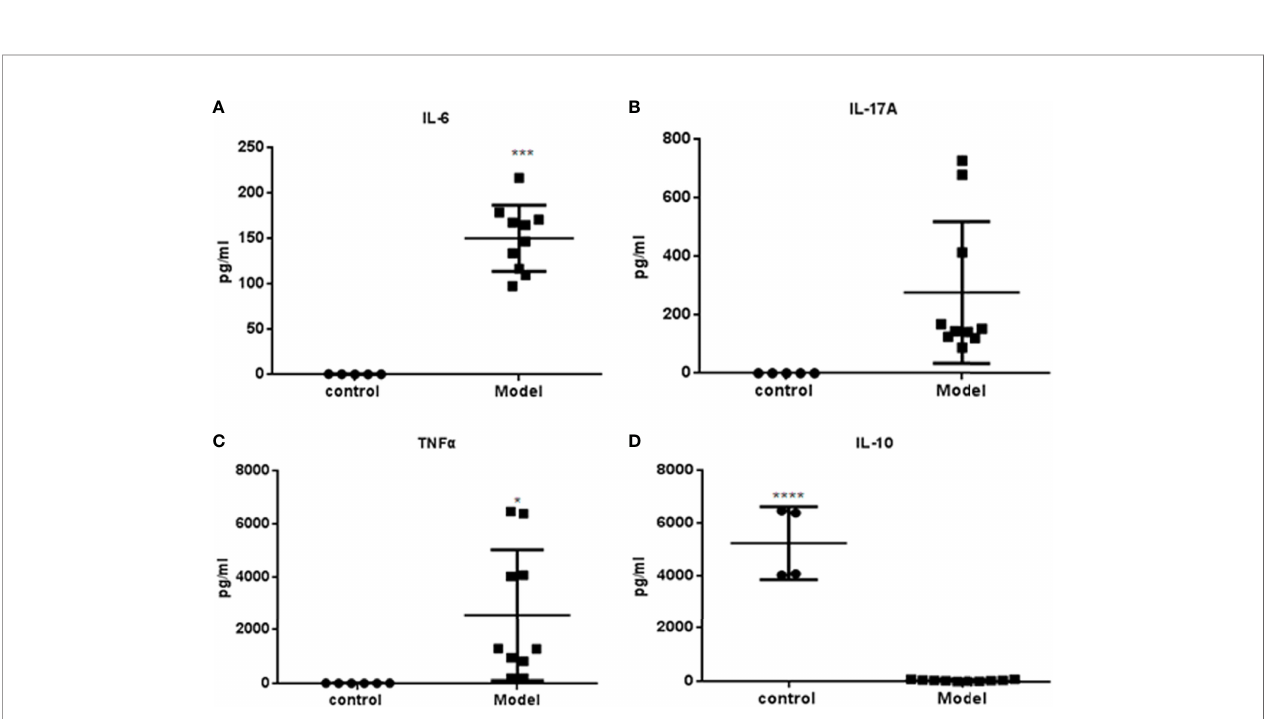
FIGURE 4 | Cytokines measured by Luminex determination (R&D Systems, USA): Serum was obtained from BALB/c mice immunized with PGA or PBS at week 36. (A) IL-6; (B) IL-17A; (C) TNF- a ; (D) IL-10. The expressions of IL-6, IL-17A and TNF a were higher in the PGA-induced model group compared with those in the control group. The expression of IL-10 in the PGA-induced model group was lower than that in the control group (control group = 4, PGA-induced model group = 9). *p < 0.05; ***p < 0.01; ****p < 0.001, compared with control